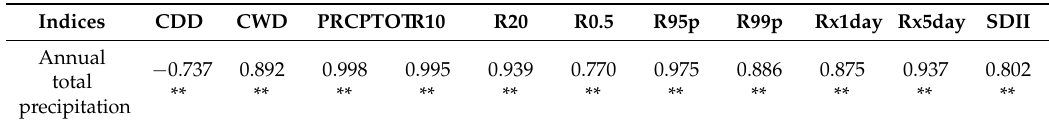
Table 3. Correlations between precipitation indices and annual total precipitation in the IMP during